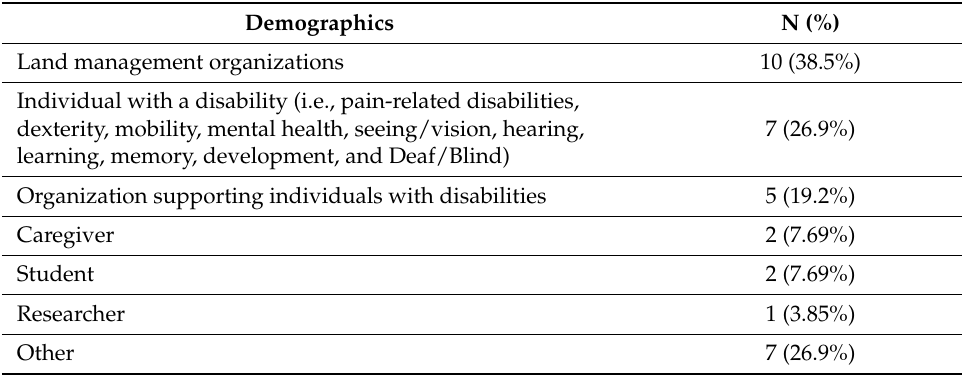
Table 5. Respondent demographics.